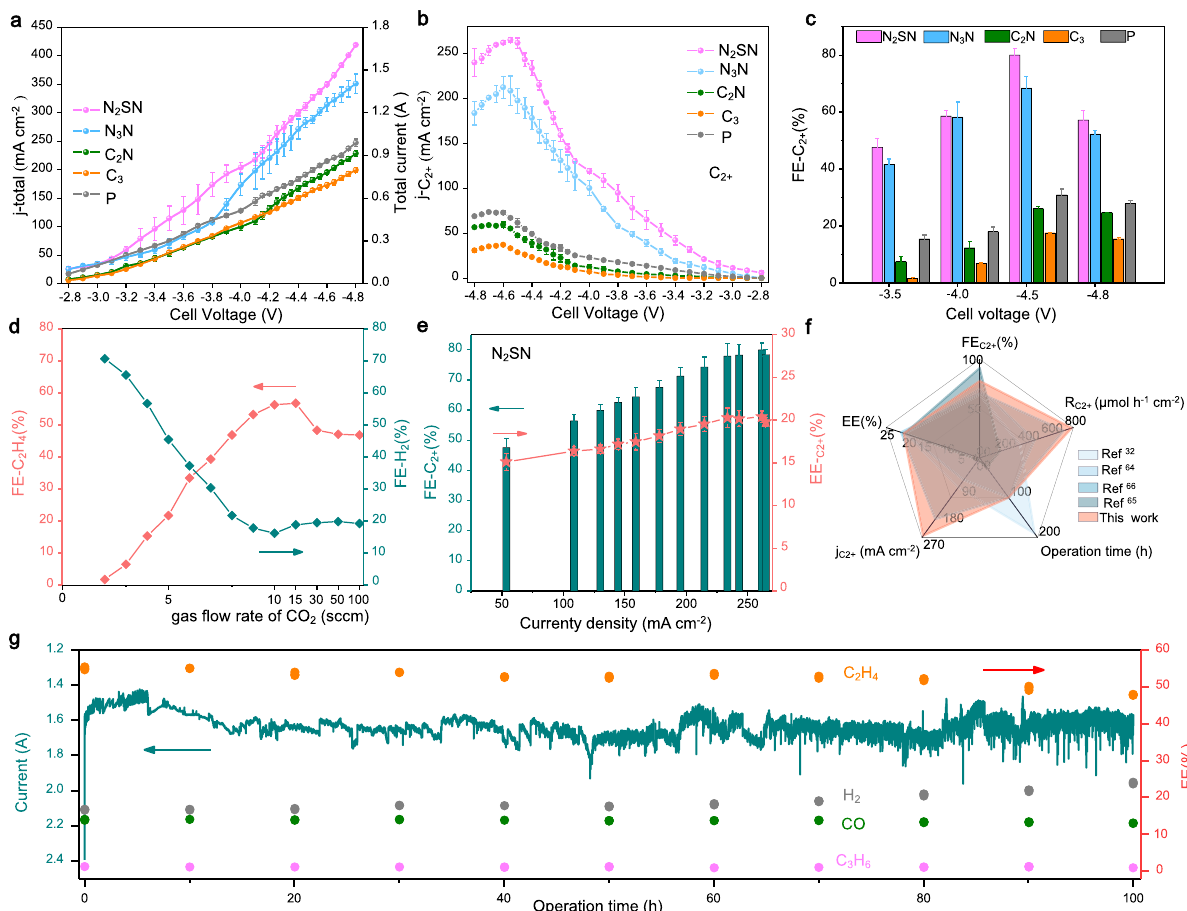
Fig. 4 CO 2 RR performance of the functionalized Ag – Cu electrodes measured in MEA electrolyzers. a Relationship between the current and cell voltage relationship of pristine, C 3 -, C 2 N-, N 3 N- and N 2 SN- functionalized electrodes. The CO 2 RR electrolysis was operated using CO 2 with a fl ow rate of 10 sccm, 0.1 M KHCO 3 anolyte with a fl ow rate of 30 mLmin − 1 . b Corresponding partial current density for the C 2 + products. c Comparison of FEs for C 2 + on the different Ag – Cu electrodes measured at full-cell potentials ranging between − 3.5 and − 4.8 V. d Evolution of the Faradaic ef fi ciency for C 2 + and H 2 with the CO 2 fl ow rate. e Evolution of the FEs and full-cell energy ef fi ciency (EE) for C 2 + as a function of speci fi c current densities for C 2 + on the N 2 SN- functionalized Ag – Cu electrode. The error bars represent the standard deviation of three independent samples measured under different current densities. f Comparison of the performance metrics of the MEA electrolyzers based on N 2 SN-functionalized Ag – Cu cathodes with literature benchmark. For each report, the plotted values are those corresponding to the longest duration test 32, 65 – 67 . The references are from refs. 32 , 65 , 66 , and 67 . g CO 2 RR performance of N 2 SN-Ag – Cu catalyst at a full-cell potential of − 4.55 V and with a 10 sccm feed in CO 2 over 100 h. The anolyte consisted in a 0.1 M KHCO 3 solution with a fl ow rate of 30 ml min − 1 . The blue line represents the current recorded during the extended CO 2 RR experiment (primary y axis). Each orange, gray, green, and purple spheres represent the FEs for C 2 H 4 , H 2 , CO and C 3 H 6 averaged from three independent measurements (secondary y axis). The error bars in a , b , c , and e represent the standard deviation of three independent